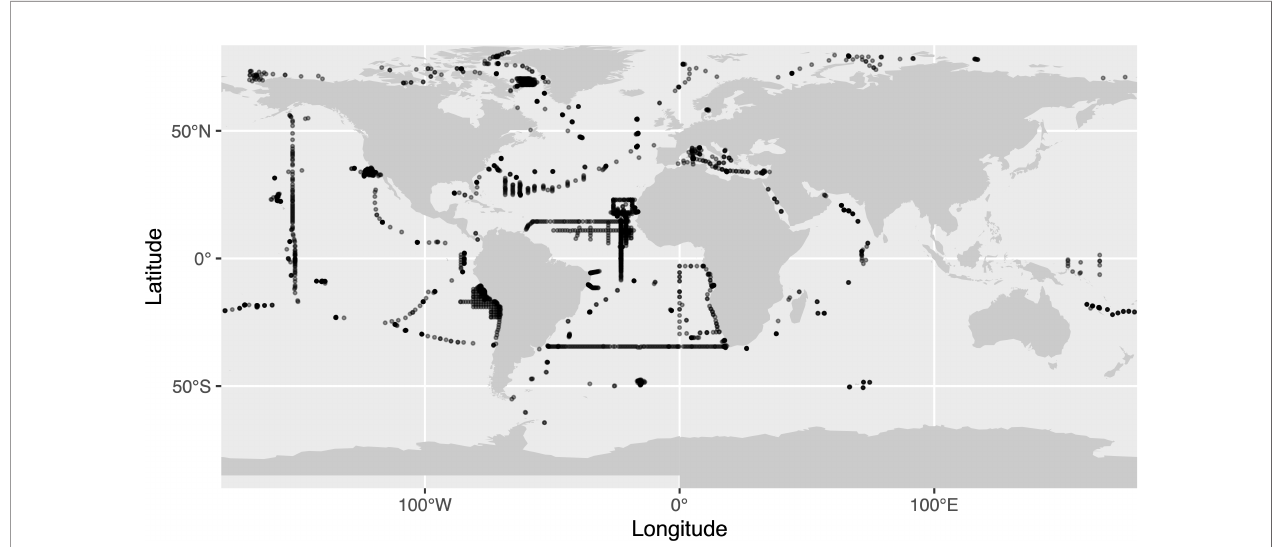
FIGURE 1 | Map of the UVP5 dataset used in this study. Transparency was used to illustrate the density of points on the